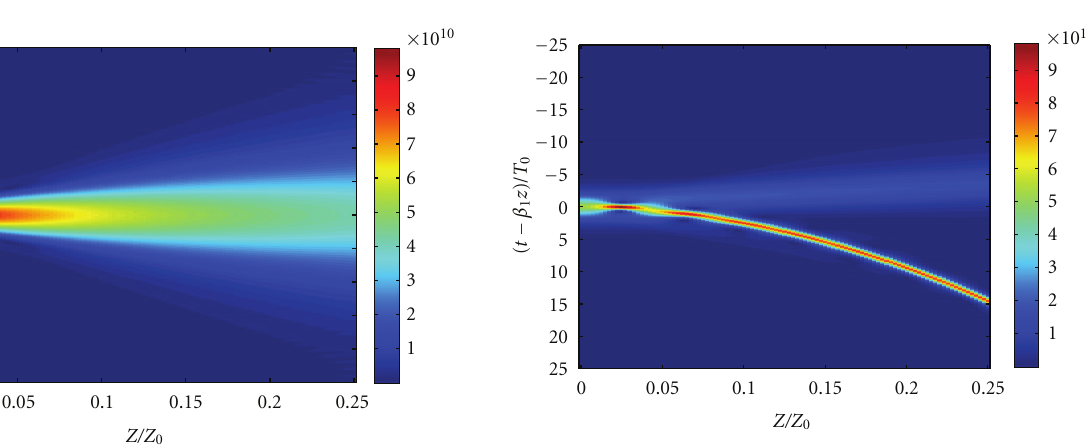
Figure 2: Temporal evolution at propagation distance of 25-cm for pump wavelength λ = 850 nm. Only dispersion is taken into account.